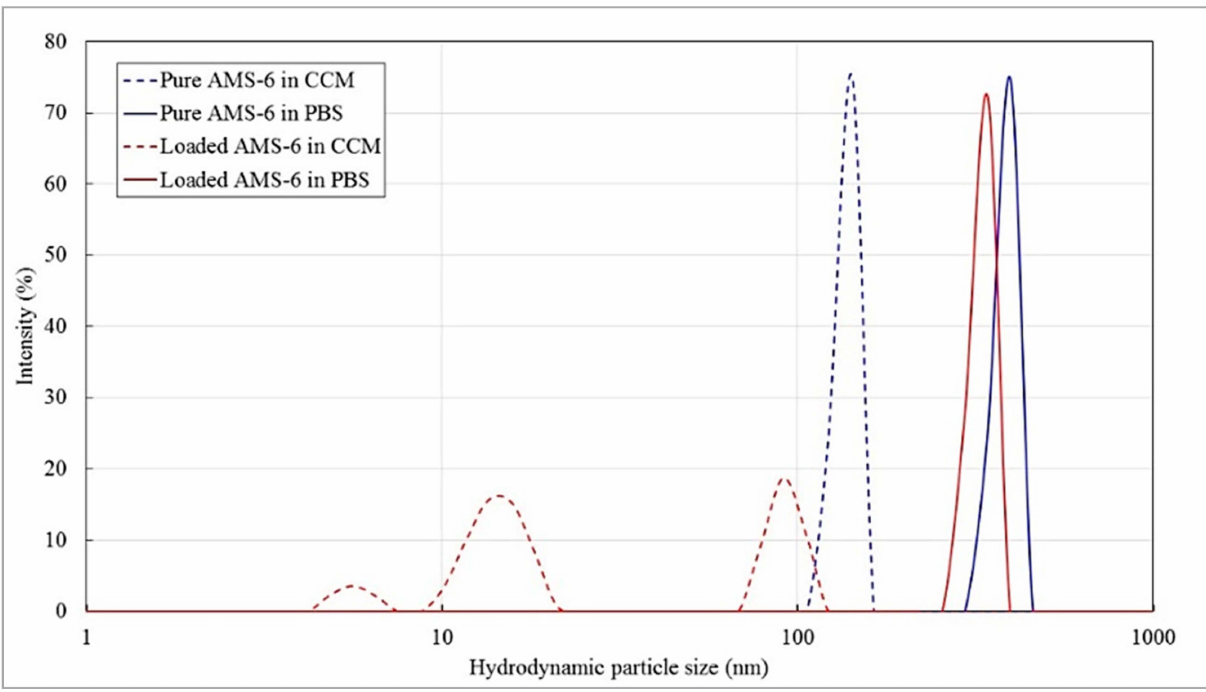
Figure A20. Hydrodynamic size distribution of pure and loaded AMS-6 NPs in complete culture medium (CCM) and in PBS. Note the variation of the particles’ size distribution depending on the used dilution medium.